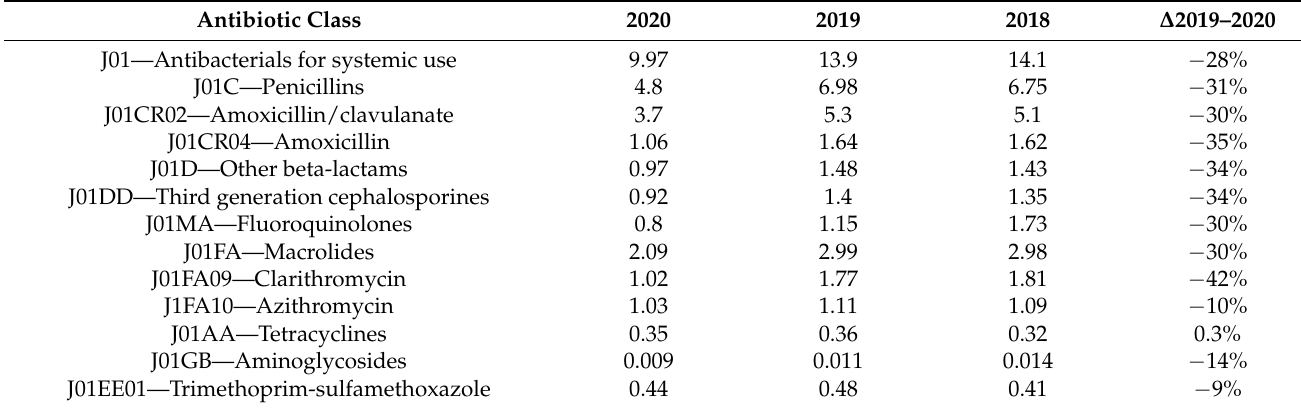
Table 1. Antibiotic use in the out-of-hospital setting during the study period (DDD/1000 inhabi-